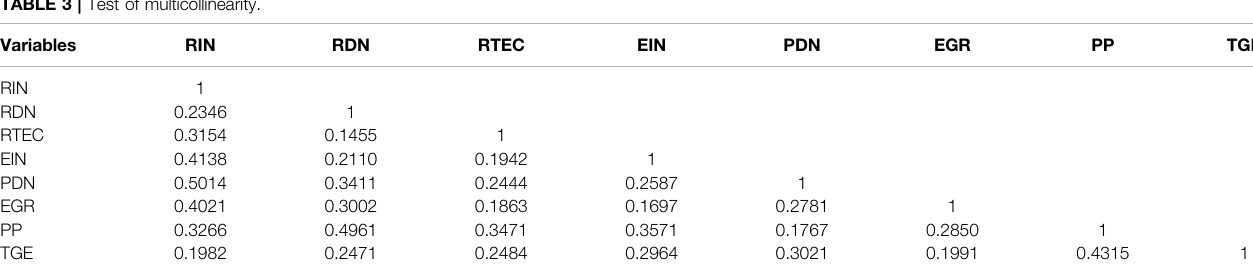
TABLE 3 | Test of multicollinearity.